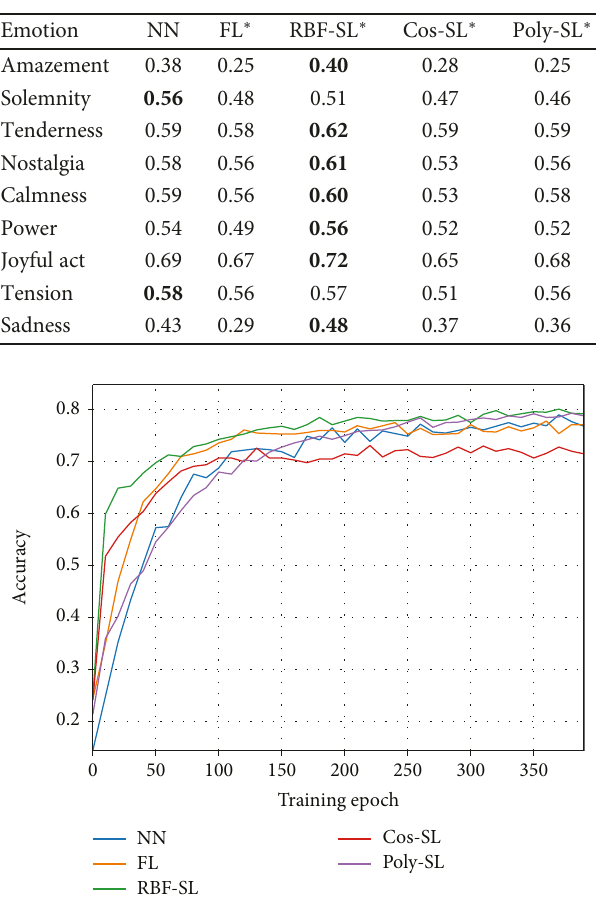
Figure 4: Classi fi cation performance on GTZAN